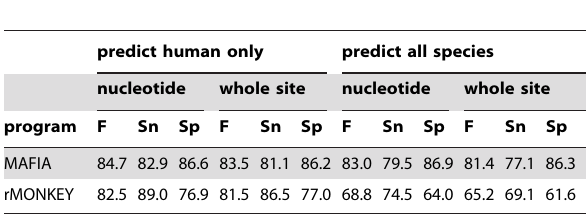
Left half of table: accuracy of predictions in human. Right half of table: pooled accuracy over all leaf species. For site-level accuracy, a known site must overlap a predicted site of the same factor by at least half its nucleotides to be counted correct. All numbers are percentages, averaged over 300 simulation runs.